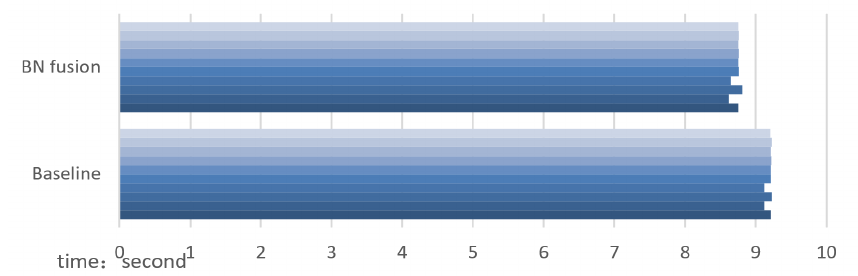
Figure 5. Processing time of each